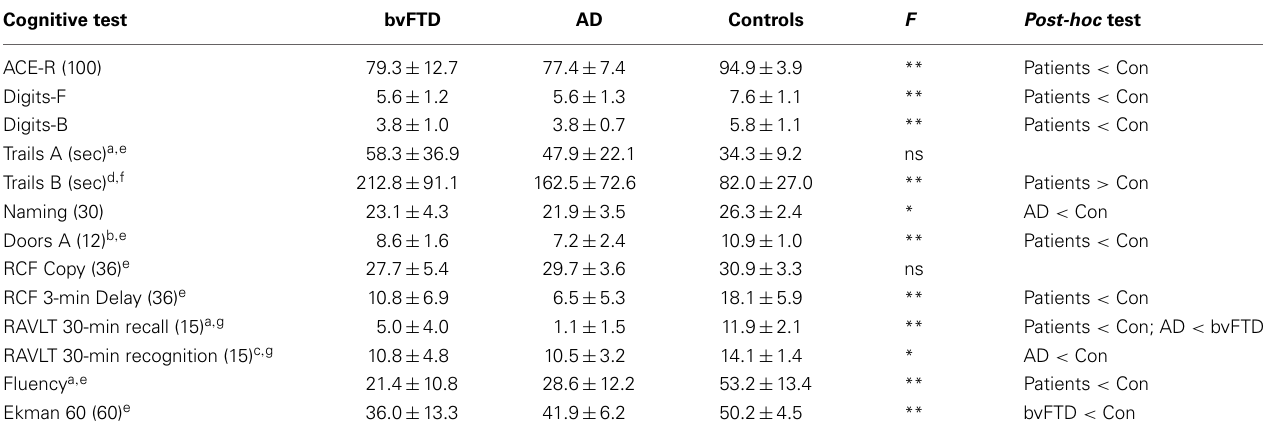
Table 3 | Performance on neuropsychological tests for the study samples. Cognitive test